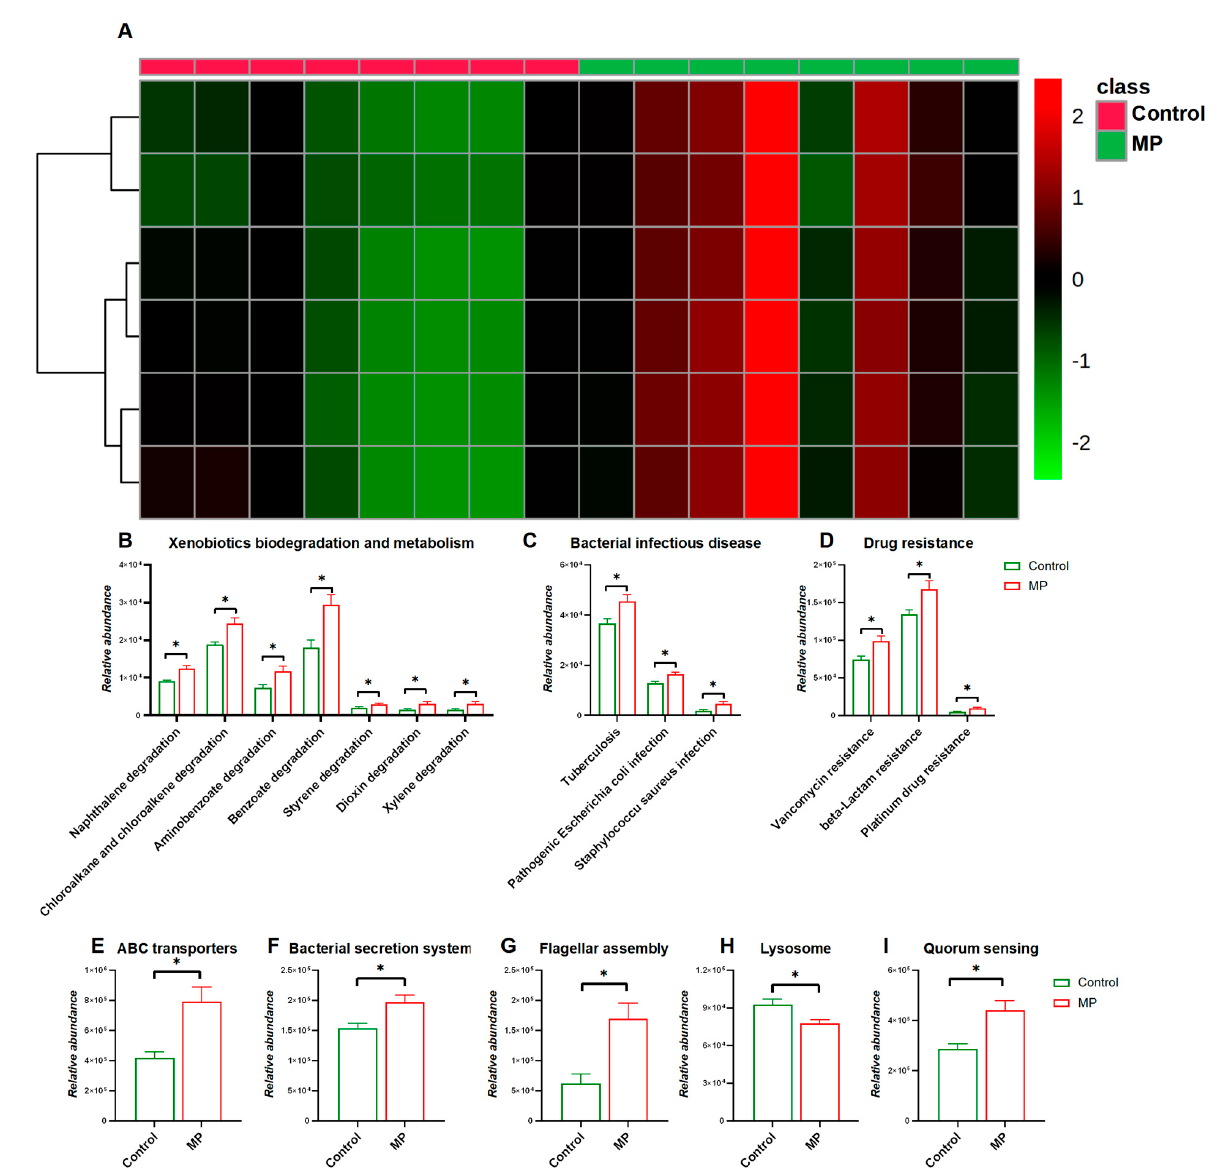
Figure 3. Comparisons of Functional pathways ( n = 8). ( A ) Heatmap constructed by abundances of bacterial pathways at KEGG Level 1. The abundance of pathways related to xenobiotic biodegrada- tion and metabolism ( B ), bacterial infectious disease ( C ), and drug resistance ( D ). The abundance of pathways related to ABC transporters I, bacterial secretion system ( F ), flagellar assembly ( G ), lysosome ( H ), and quorum sensing ( I ). *, p < 0.05.